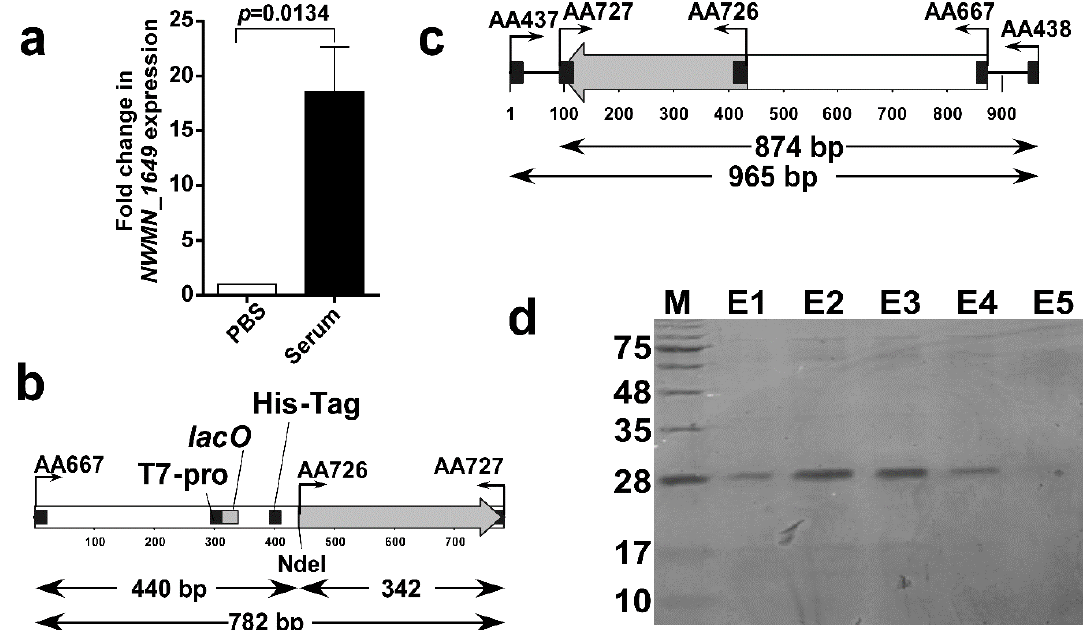
Figure 3. Expression of the NWMN_1649 gene and cloning and expression of the selected polypeptide as a 6xHis fusion. ( a ) Relative expression of the gene encoding NWMN_1649 protein in presence of heat-inactivated human serum. The data presented is the mean of three independent experiments and the error bars represent the standard error. The level of the expression in the presence of PBS was used as a calibrator and the level of expression of the 16S rRNA was used as a normalizer. The statistical significance was determined by the student’s t-test with a p -value < 0.05. ( b ) Schematic map of the PCR-ligated fragments, the position of the binding of the respective primers is indicated on the map and the predicted sizes of the respective fragments are indicated below the map. ( c ) Schematic map of the of the multicloning site of pNWMN_1649-6xHis showing the binding sites of different primers and the predicted sizes of the PCR products, the maps in both c and d were generated using the BioEdit Sequence Alignment Editor, v. 7.1.3.0. ( d ) Photograph of 15% SDS-PAGE gel showing the elution fractions “E” of the purification of the cell lysates of the E. coli cells carrying the pNWMN_1649-6xHis. The first lane contained a protein marker for molecular mass